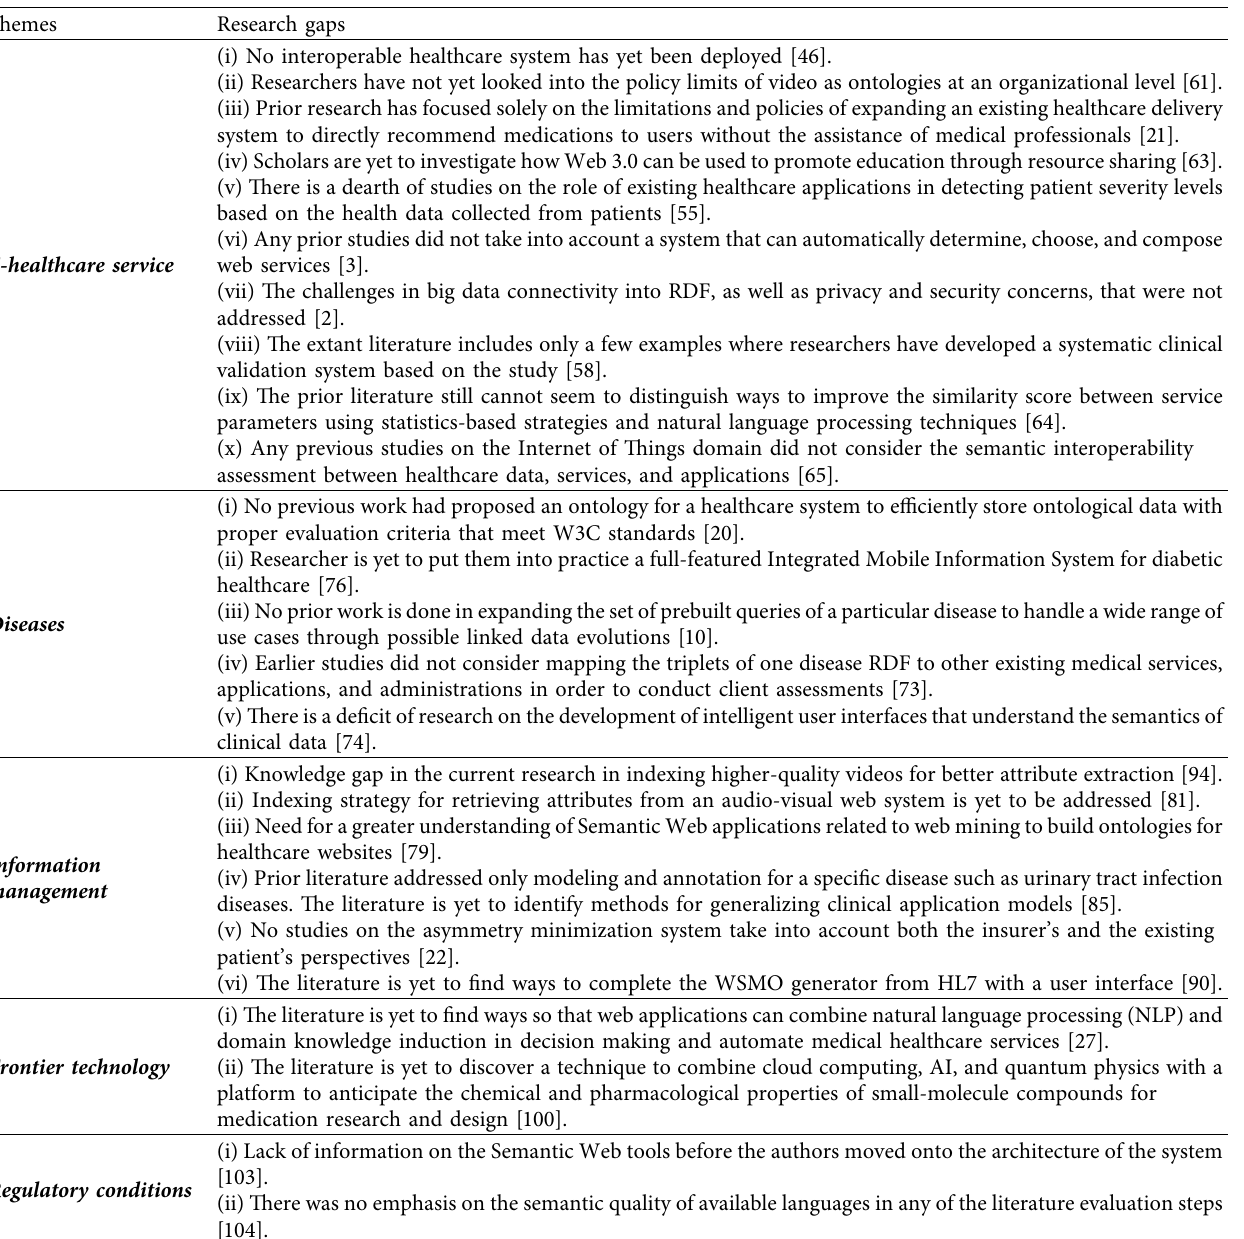
Table 4: Summarization of the research gaps and future research